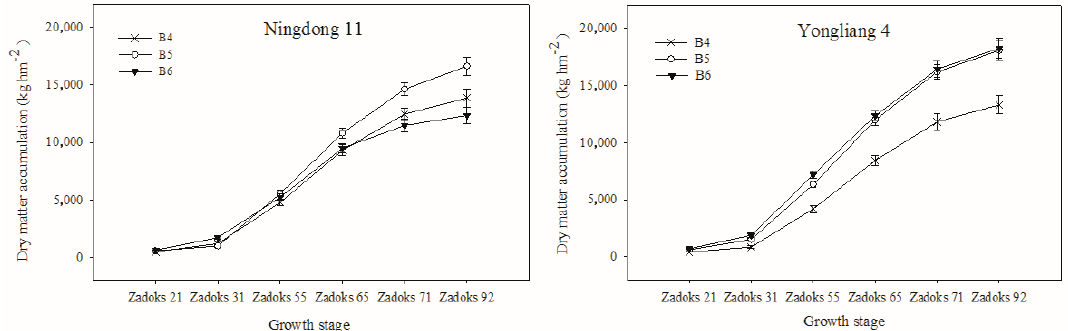
Figure 2. The change in dry matter accumulation (DMA) of wheat sown on di ff erent dates (2014–2015).